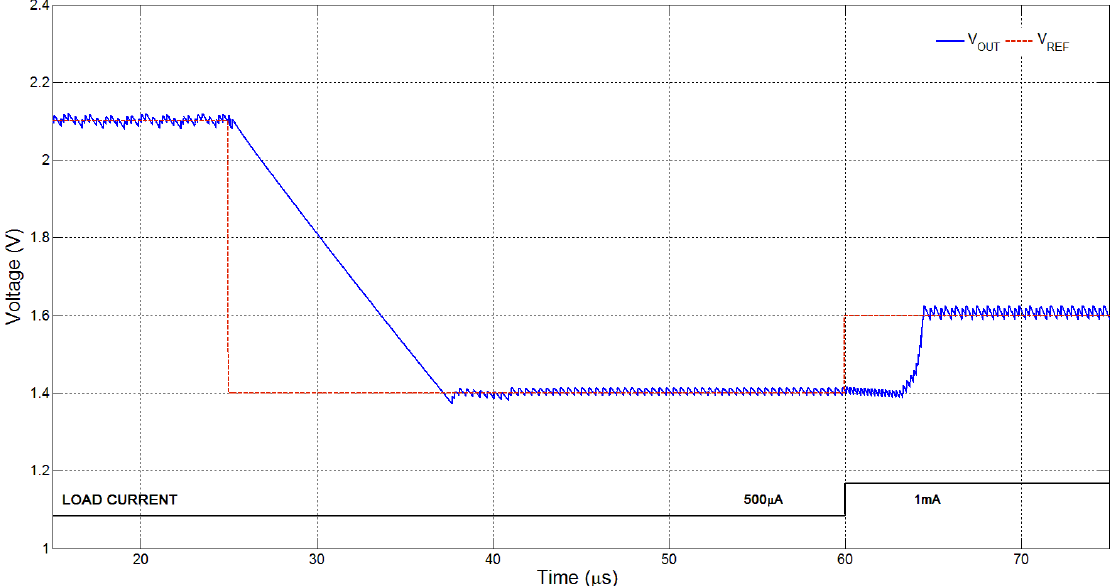
Figure 7. Simulation plot showing an example of voltage tracking.